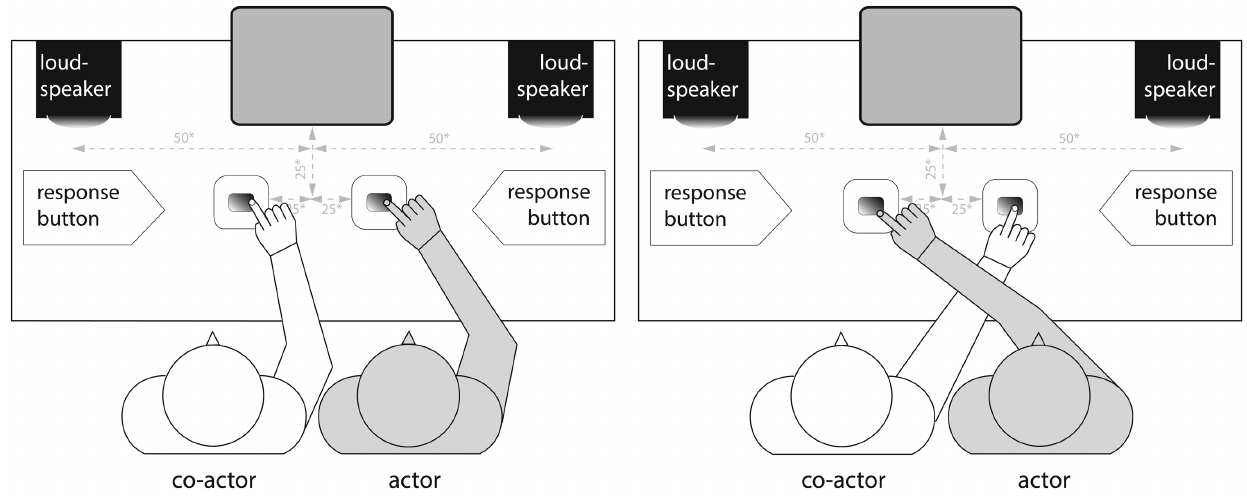
Figure 1. Experimental Design. Gray shaded participant depicts the actor, while the white shaded participant depicts the co-actor. Participants performed the Joint Simon task under ‘hands uncrossed’ (left panel) and ‘hands crossed’ (right panel) conditions. Gray dashed arrows illustrate the distance between loudspeaker and response buttons in cm (*). doi:10.1371/journal.pone.0059008.g001 PLOS ONE |